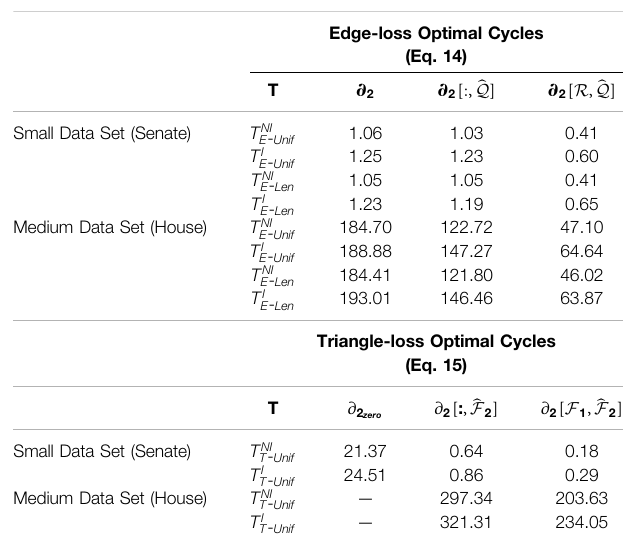
small-sized data set ( Senate ) that consists of 103 points in dimension 60 and a medium-sized data set ( House ) that contains 445 points in dimension 261. For edge-loss methods, we consider three implementations to solve these optimization problems: using the full boundary matrix z 2 , using the basis columns and all rows z 2 [ : , (cid:9) Q ] , and using the basis columns and deleting rows corresponding to edges born after the birth time of the cycle z 2 [ R , (cid:9) Q ] . For triangle-loss methods, we consider three approaches to solve these optimization problems: zeroing out the columns in the boundary matrix , deleting columns outside of this range outside of [ b i , d i ] denoted as z 2 zero